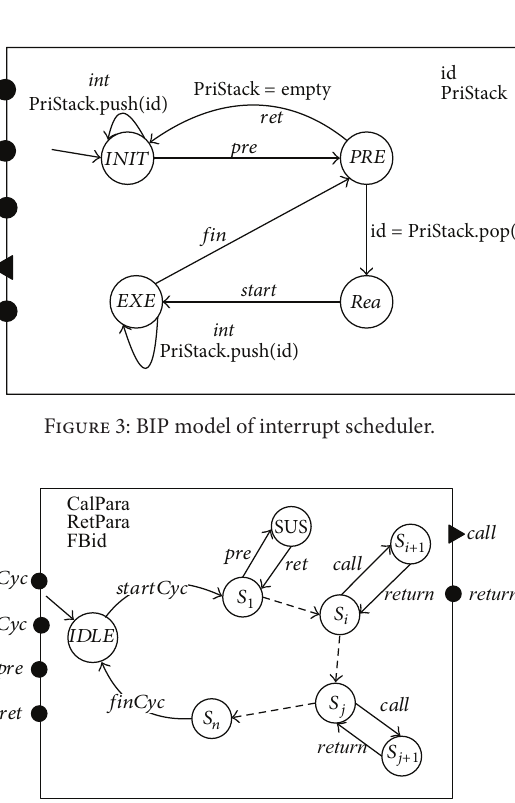
Figure 2: BIP model of cyclical scheduler.